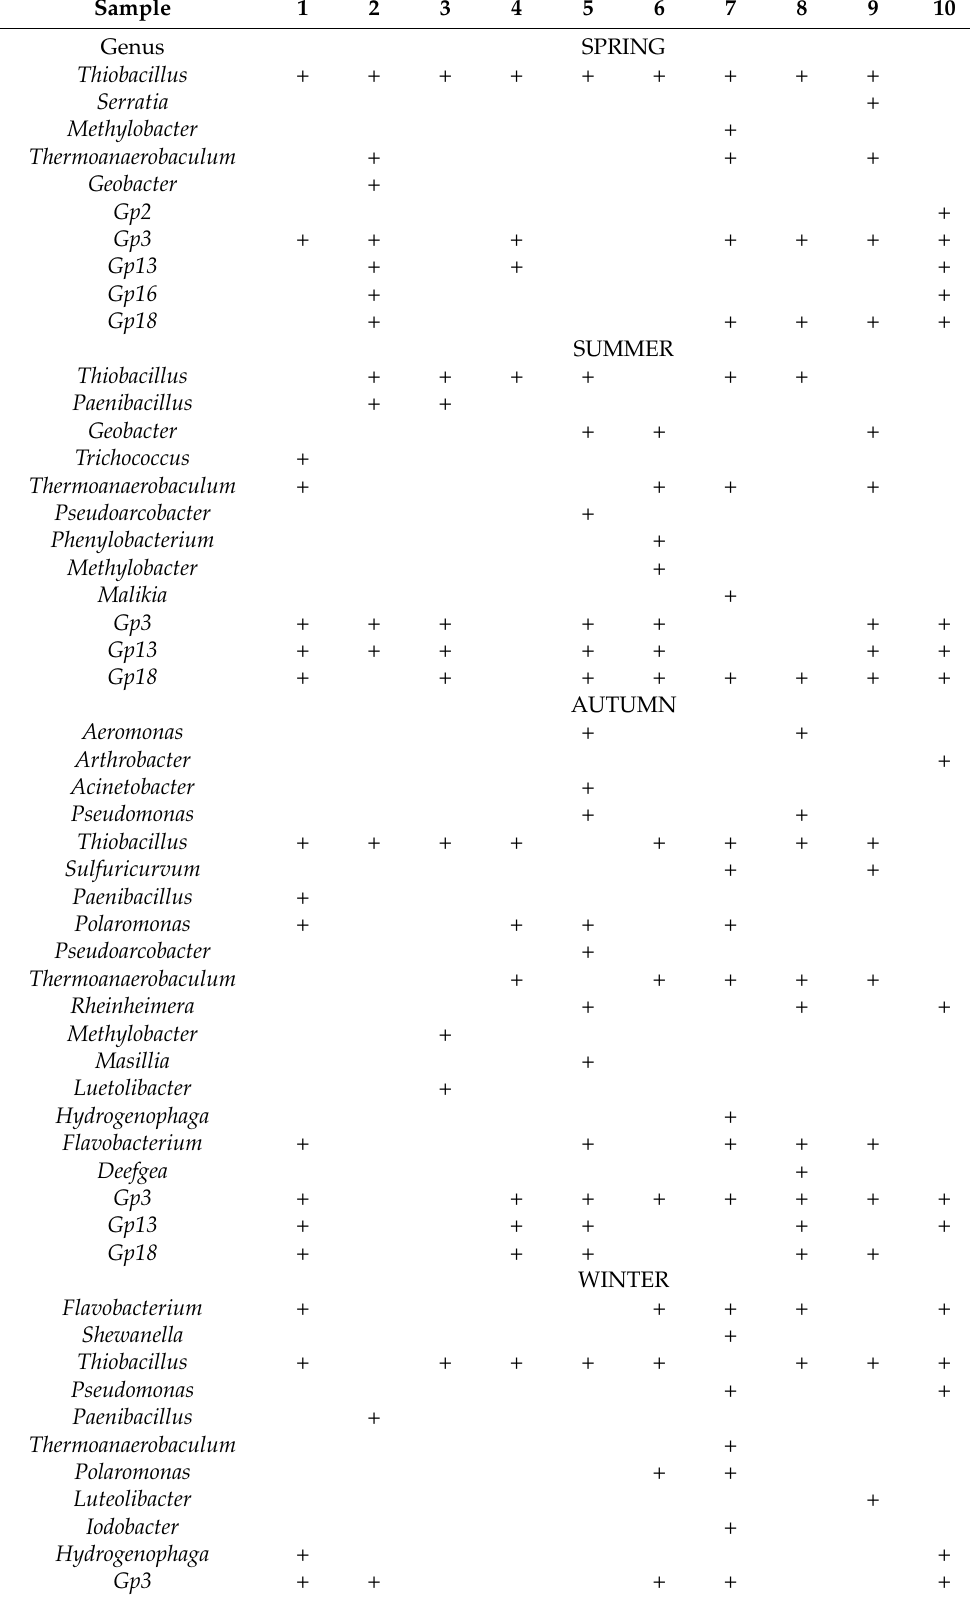
Table A1. Genus-classified bacteria present in the bottom sediments and their seasonal variation (+ indicates the presence of a particular